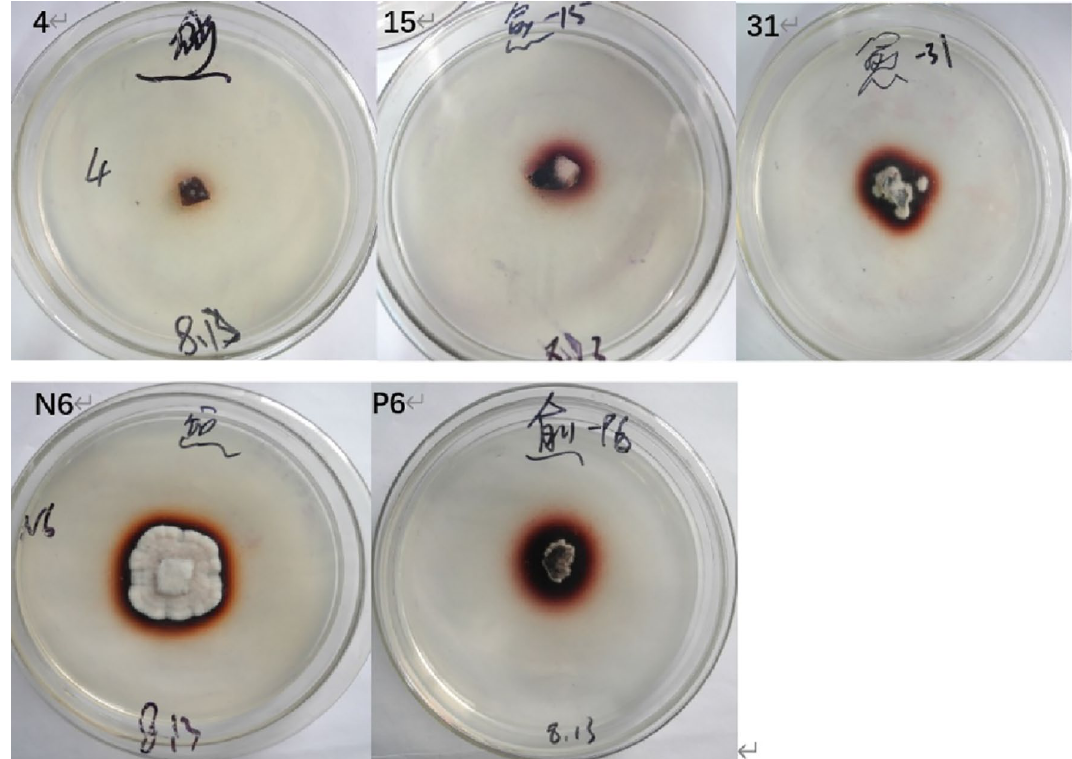
Figure 1. Growth diagrams of different strains on the PDA color plate on the 7th day. Note : 4 represents Colletotrichum acutatum ; 15 represents Nigrospora sphaerica ; 31 represents Exserohilum rostratum ; N6 represents Diaporthe phaseolorum ; P6 represents Pestalotiopsis arceuthobii